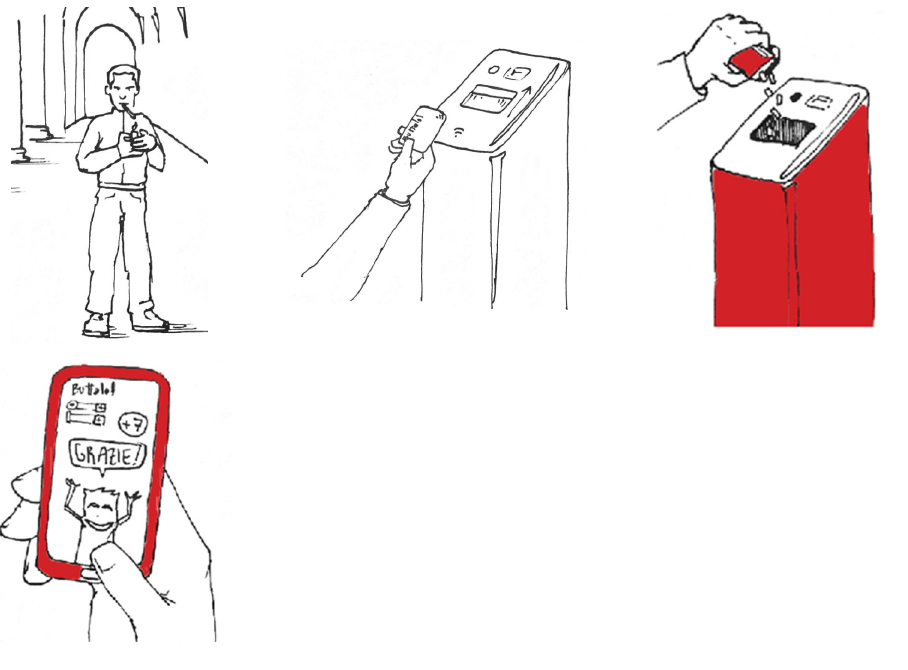
Figure 8. “Buttalo” system.